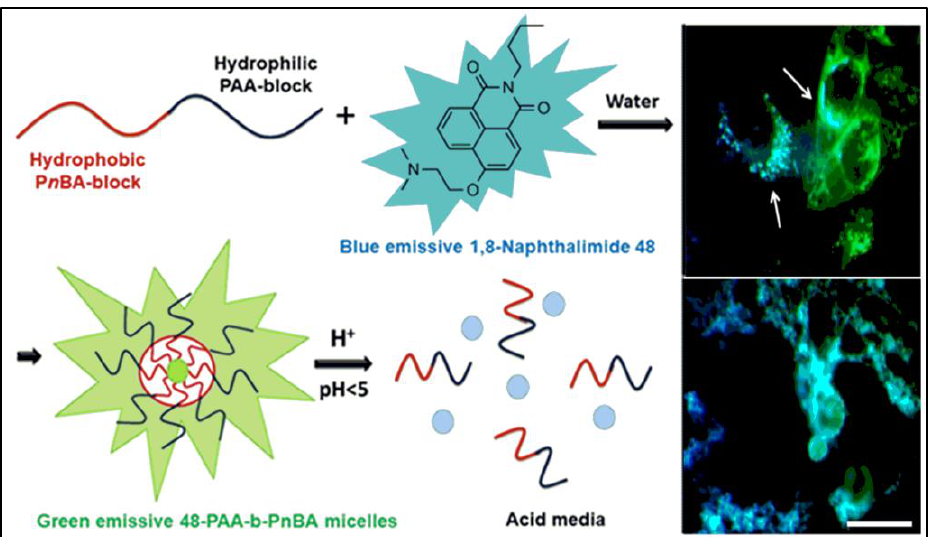
Figure 46. Preparation of pH-sensitive fluorescent 48 -PAA-b-P n BA micelles and internalization in living A549 cells visualized by fluorescent microscopy. The cells were incubated for 24 h with fluorescent micelles in different concentrations (0.155 mg/mL — upper image; 0.250 mg/mL — lower image). Bar scale is 50 μm. Adapt ed with permission from [146]. Copyright (2021) Elsevier.